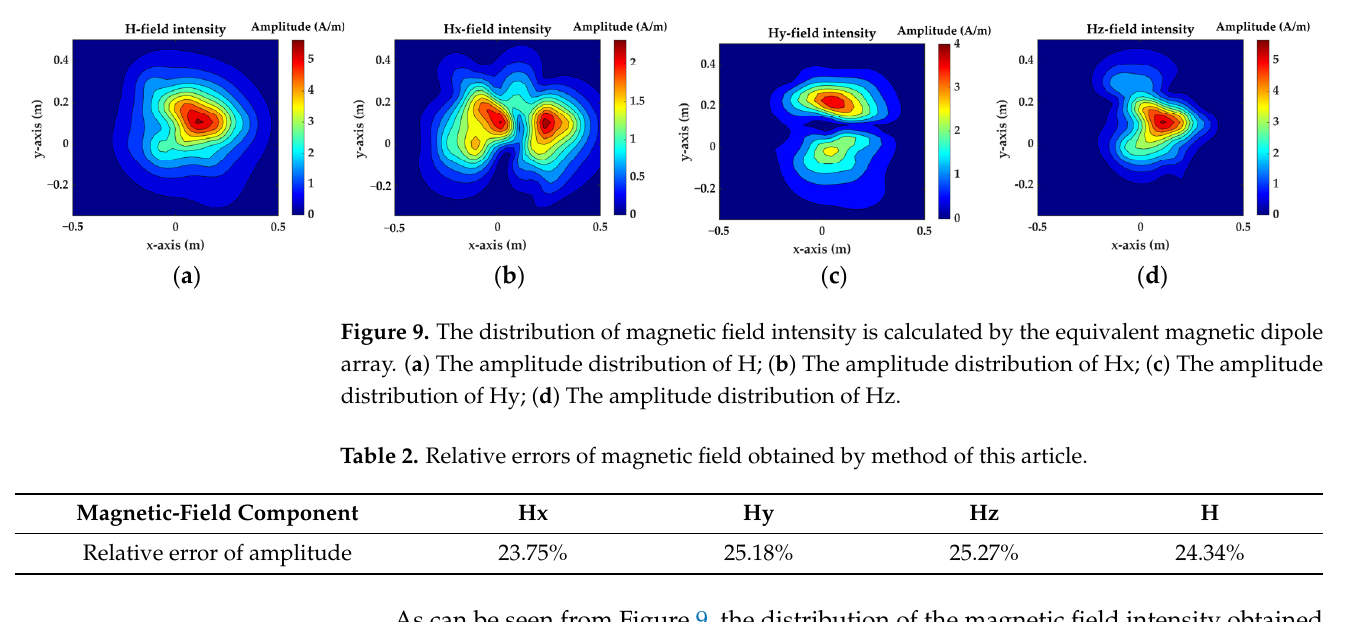
( h ) Figure 11. The distribution of the magnetic field which is calculated by the simulation model. ( a ) The amplitude distribution of H; ( b ) The amplitude distribution of Hx; ( c ) The amplitude